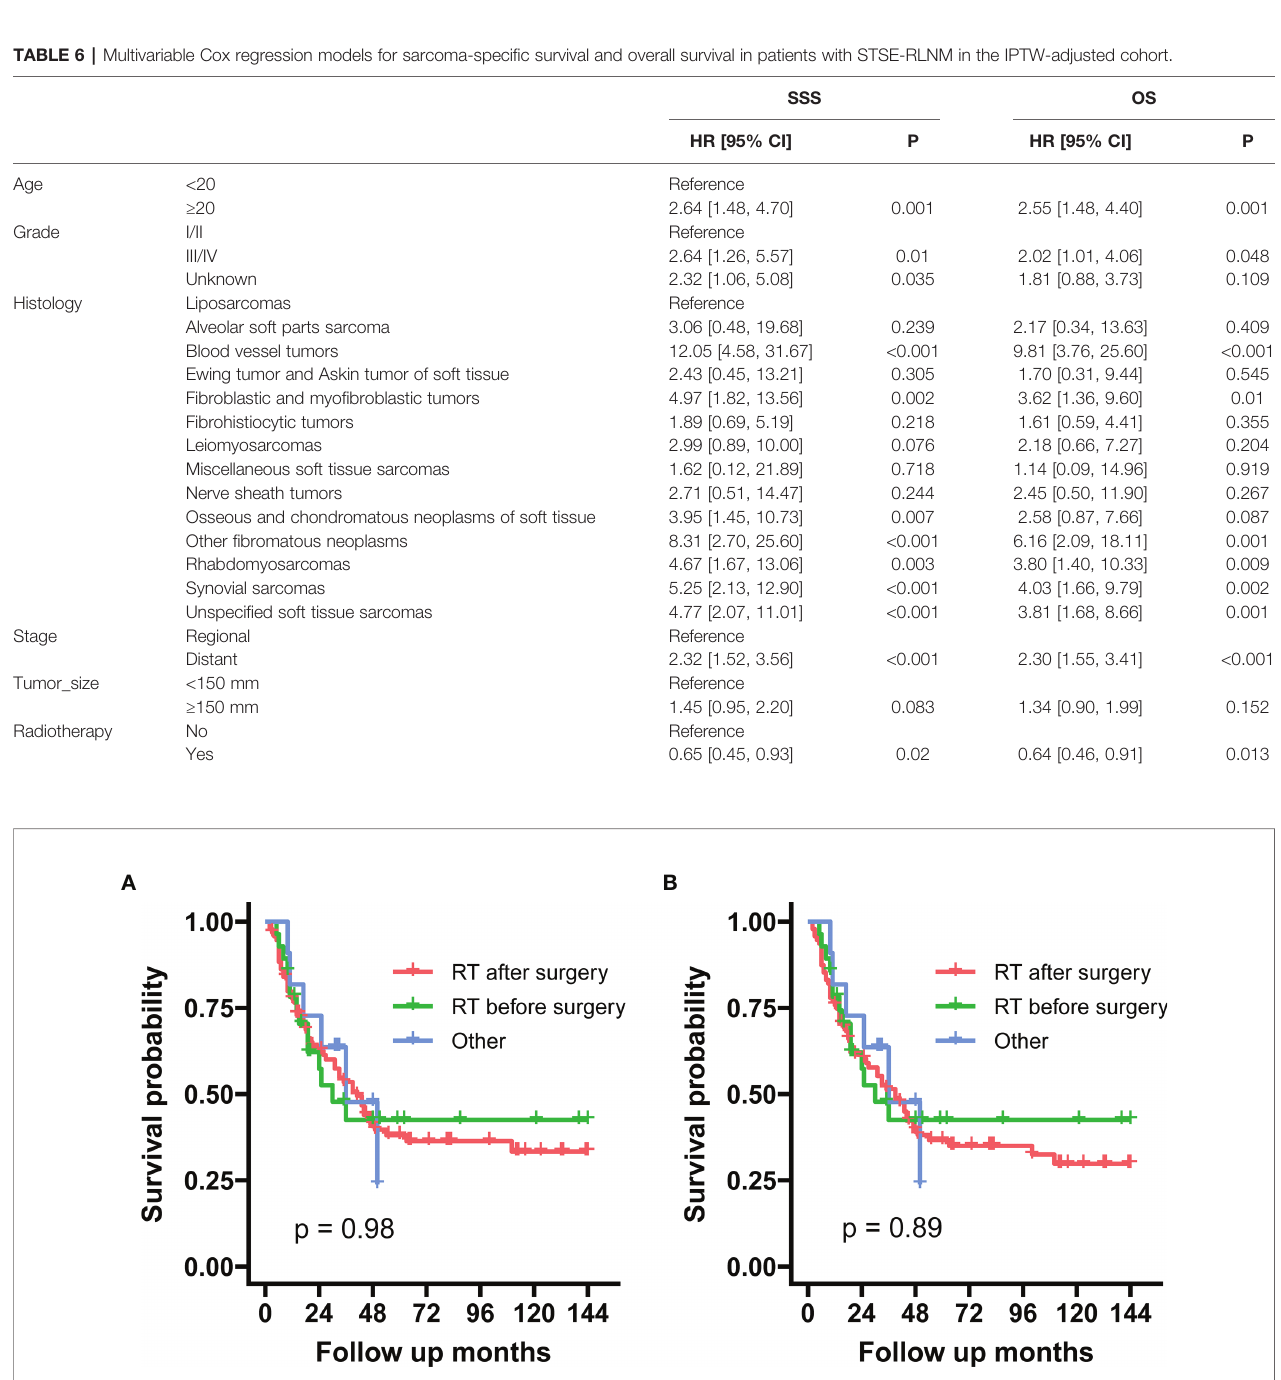
TABLE 6 | Multivariable Cox regression models for sarcoma-speci fi c survival and overall survival in patients with STSE-RLNM in the IPTW-adjusted cohort.